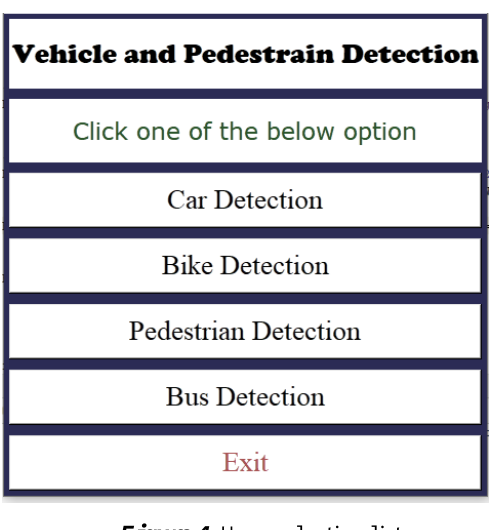
Figure 4. User selection